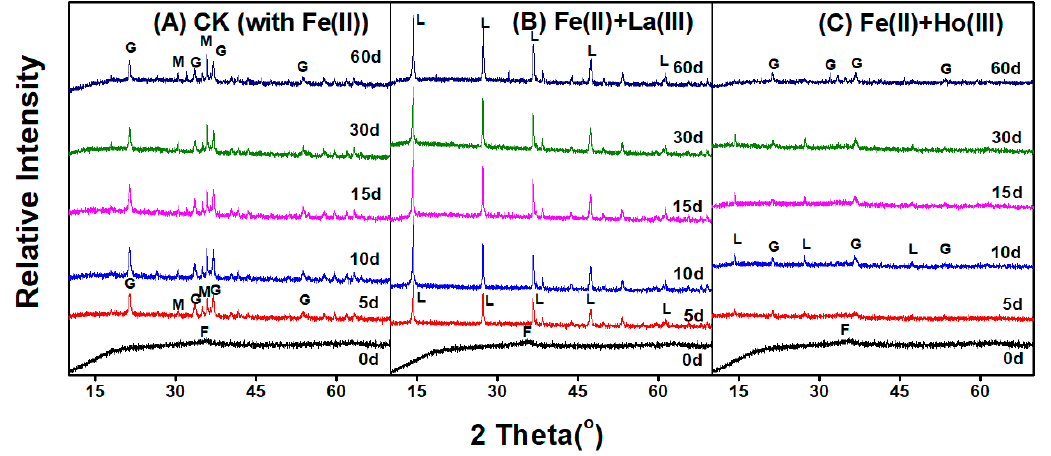
Figure 1. X-ray diffraction (XRD) patterns of the transformed ferrihydrite samples: ( A ) Fe(II) aq induced without any Ln(III); ( B ) Fe(II) aq induced with the presence of La(III); and ( C ) Fe(II) aq induced with the presence of Ho(III). The experiments were conducted at pH with 2.0 mM of Fe(II) aq and 1.0 mM of La(III) or Ho(III) under anoxic conditions. G: goethite, M: magnetite, L: lepidocrocite, F: ferrihydrite, respectively. F: ferrihydrite,